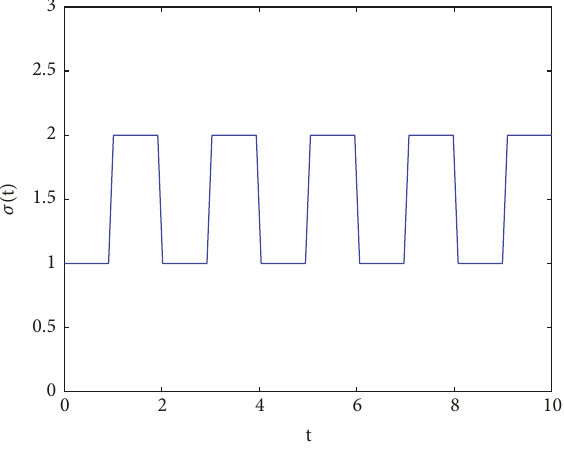
Figure 2: The given switching